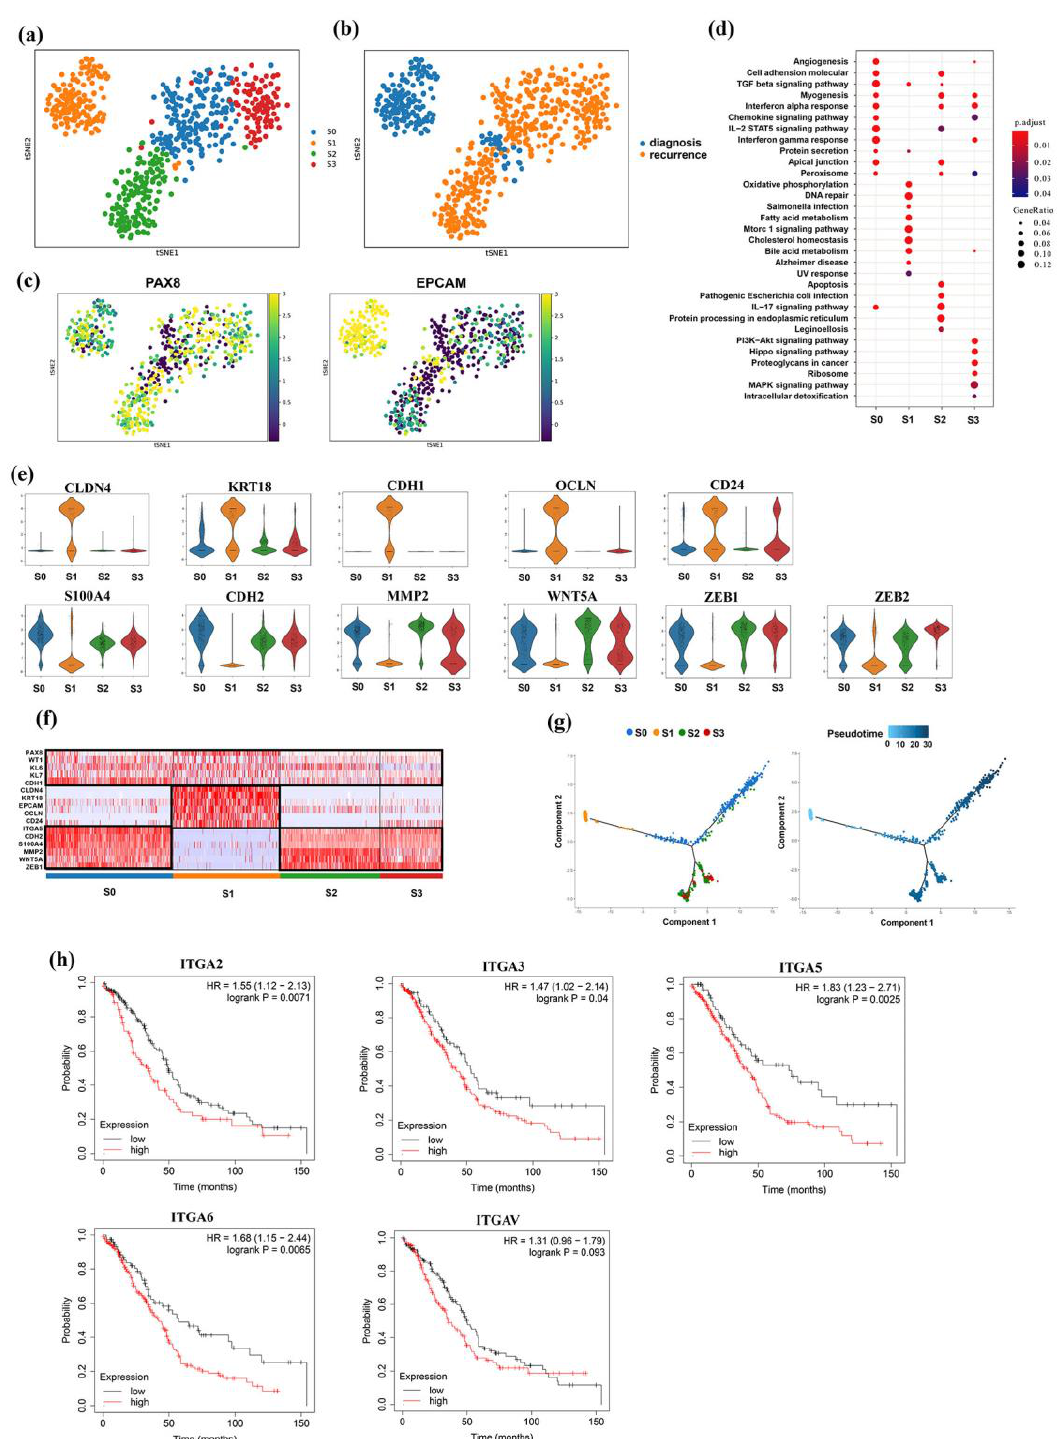
Figure 3. Identification of mesenchymal cancer cells in the progression of EOC. ( a , b ) T-SNE view of four subgroups of cancer cells, colored by subgroups ( a ) and sample groups ( b ). ( c ) The expression of PAX8 and EPCAM in the t-SNE map of diverse cancer cell subgroups. ( d ) Differential activated pathways among four subgroups of cancer cells. ( e ) Expression levels of epithelial mesenchymal transition markers in each cancer cell subgroup were plotted in violin plots. ( f ) Heatmap of representative markers for epithelial and mesenchymal cancer cells. ( g ) Pseudotime analysis demonstrates a differentiated trajectory from S1 to S0, S2, and S3. ( h ) Kaplan – Meier survival curves of integrin genes in TCGA and GEO meta-data.